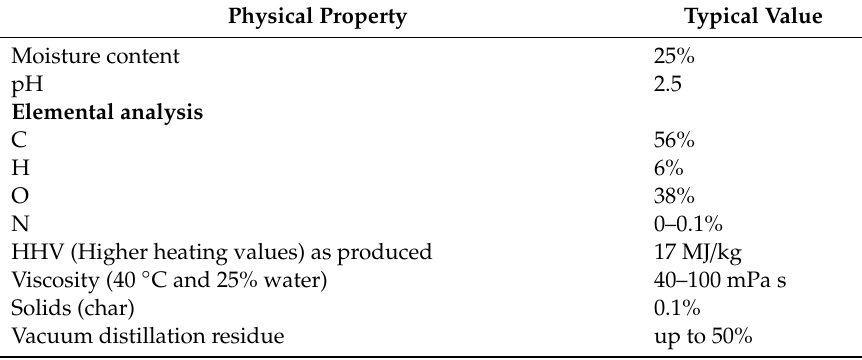
Table 3. Physicochemical properties of bio-oil produced from woody bio-mass [102].